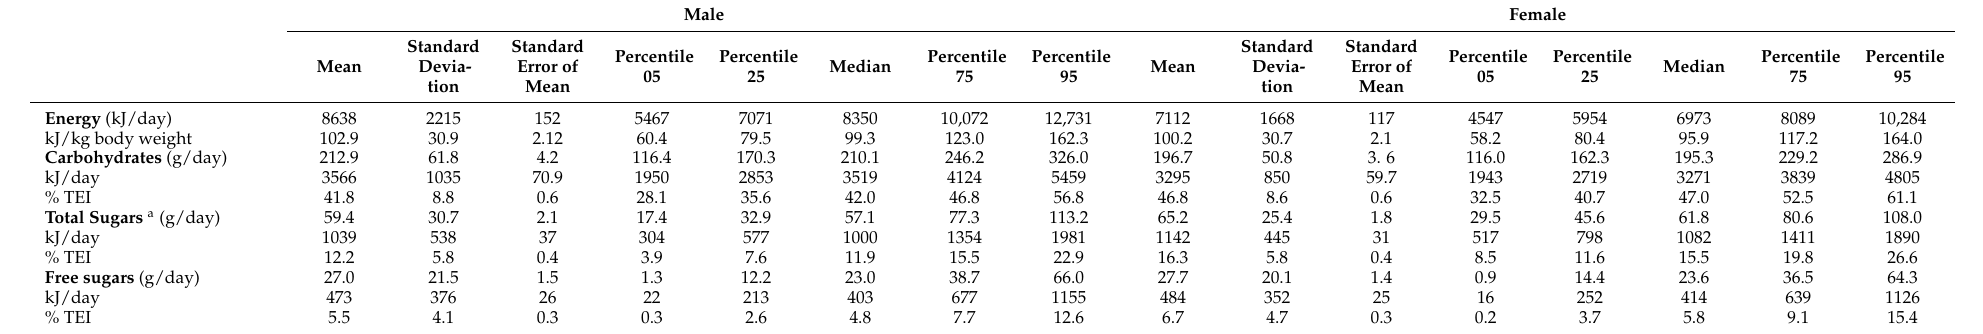
Table 5. Descriptive statistics of usual daily intakes of energy, macronutrients, and dietary fibre among elderly aged 65–74, by